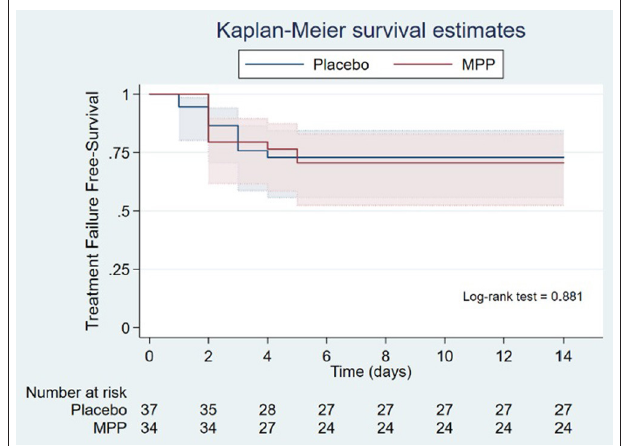
FIGURE 2 | Kaplan-Meier survival curves of the time to primary outcome (treatment failure) in the MPP and placebo groups. The time to primary outcome of the study (treatment failure) was analyzed with the Kaplan-Meier estimator and compared between the MPP and control groups using the log-rank Mantel-Cox test (1.0 [1.0–3.2] days in the MPP group vs. 1.5 [0.7– 2.0] days in the placebo group, p = 0.74). MPP, methylprednisolone